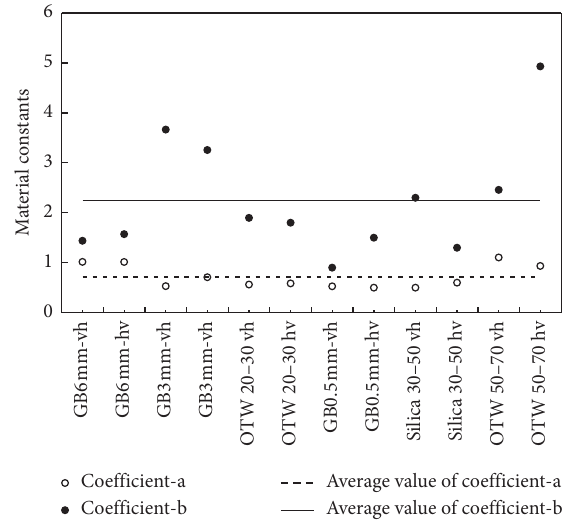
Figure 8: The fitting parameters of “ a ” and “ b ” based on equation (8) for all the test